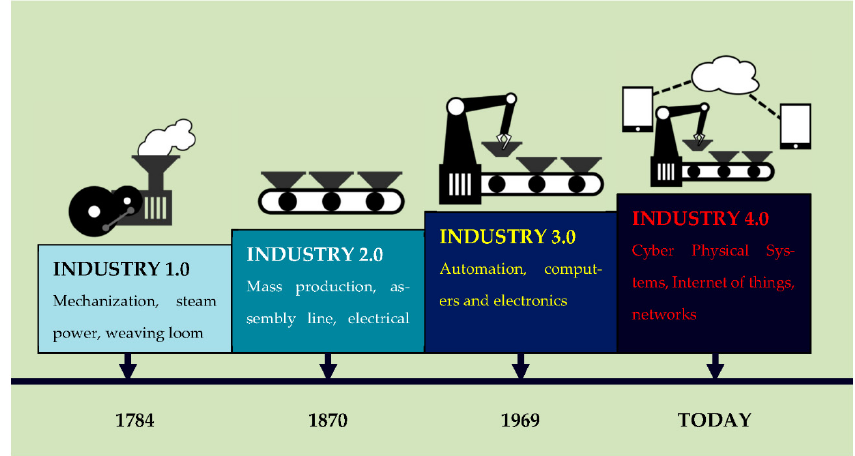
Figure 2. The four industrial revolutions adapted from (Allen and Sarkis